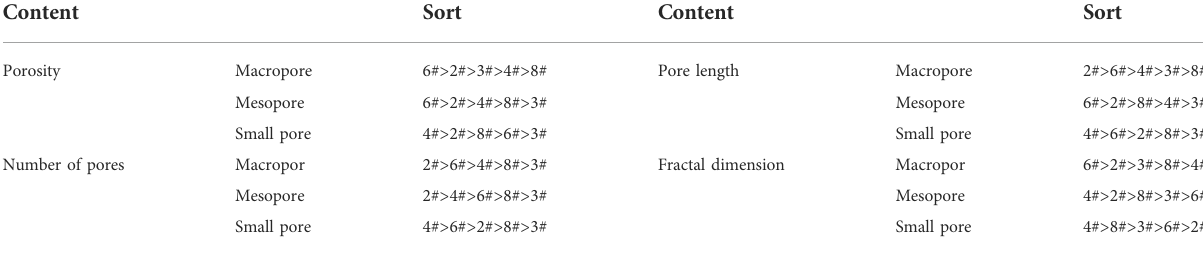
TABLE 2 Statistical comparison of PCAS of coal samples with different grades of pores. Content